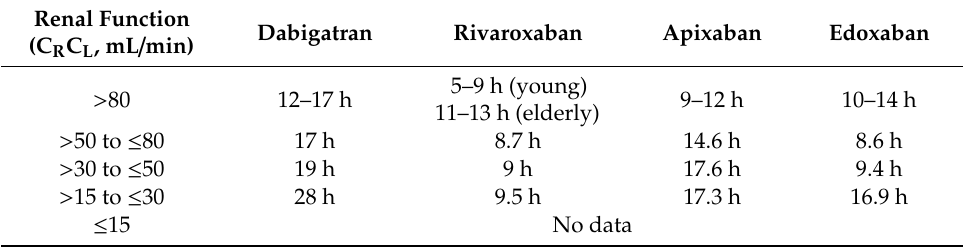
Table 4. DOACs half-life as a function of creatinine